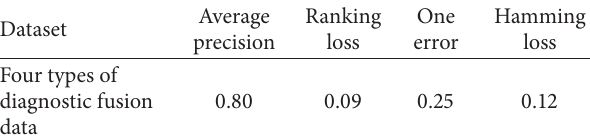
Table 3: Classification results with